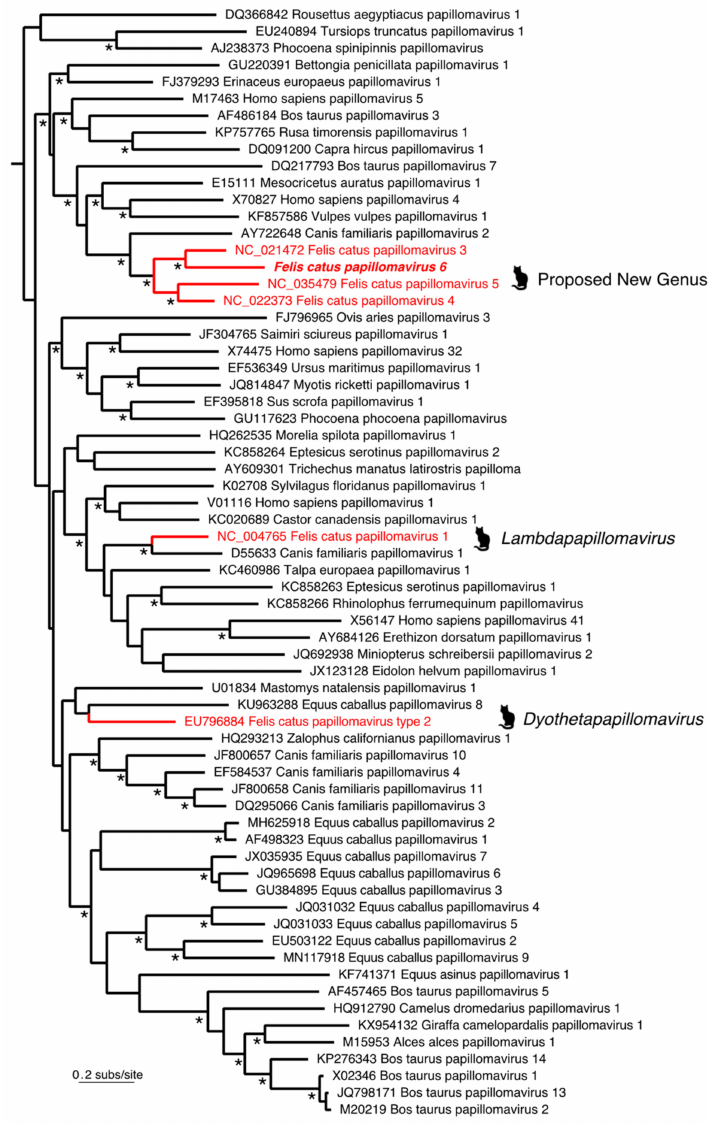
Figure 3. Evolutionary relationships of FcaPV6 to other mammalian papillomaviruses, including those previously identified in cats ( Felis catus ). Those papillomaviruses previously identified in cats are marked with animal symbols and in red, along with their respective genera. FcaPV6 is proposed to fall as part of a proposed new genus. All virus names contain their associated GenBank accession numbers. The tree is rooted using six nonmammalian papillomaviruses that have been removed to improve clarity. All horizontal branch lengths are scaled according to the number of amino acid substitutions per site, and the * denotes nodes with SH-like branch support values >